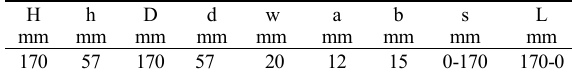
Table 1. Dimensions of the stirred vessels.